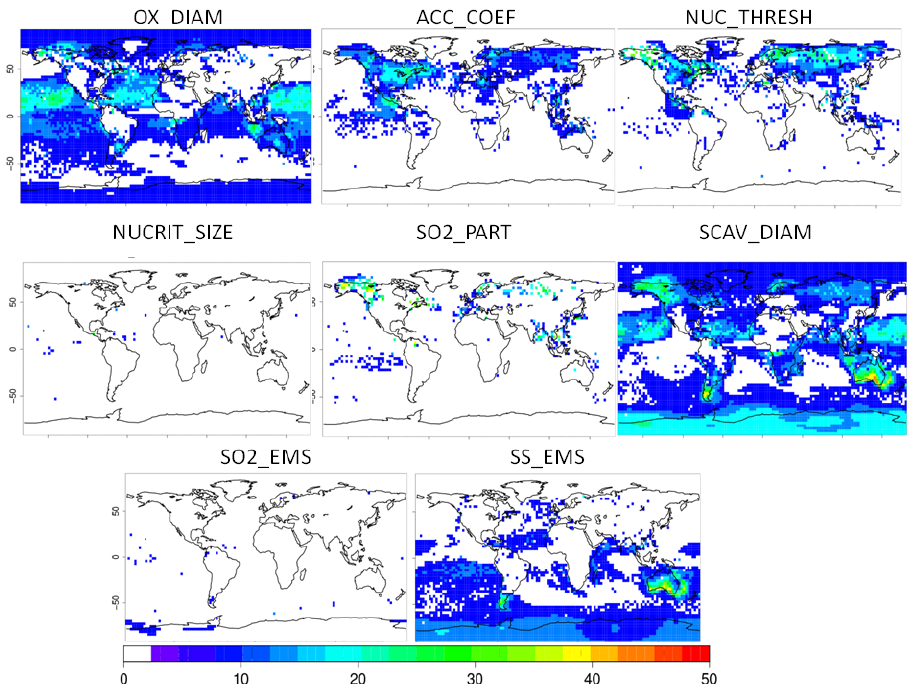
Fig. 7. The interaction effect of the individual parameters in Table 1 on July 2000 CCN uncertainty (calculated by the total effect minus the main